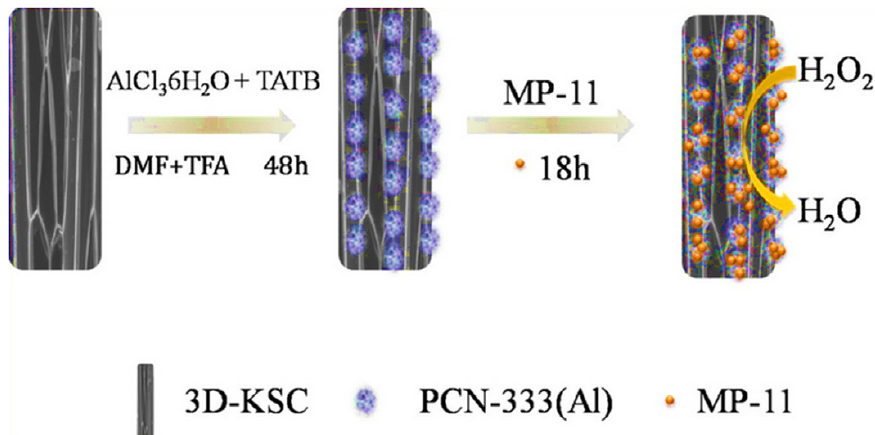
Figure 5. Schematic illustration of the stepwise fabrication process and the testing principle of the novel H 2 O 2 electrochemical biosensor. Reproduced with permission from reference [53], copyright (2016) Royal Society of